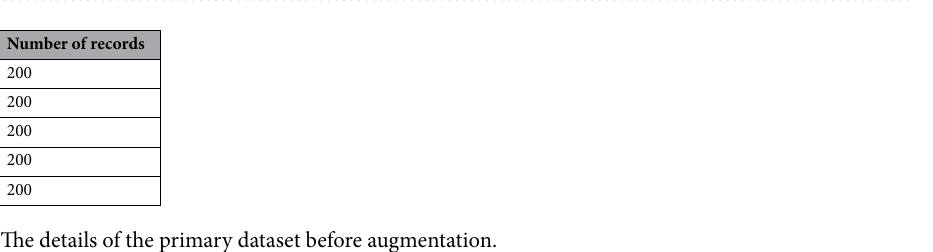
Figure 1. Block diagram of the proposed methodology.